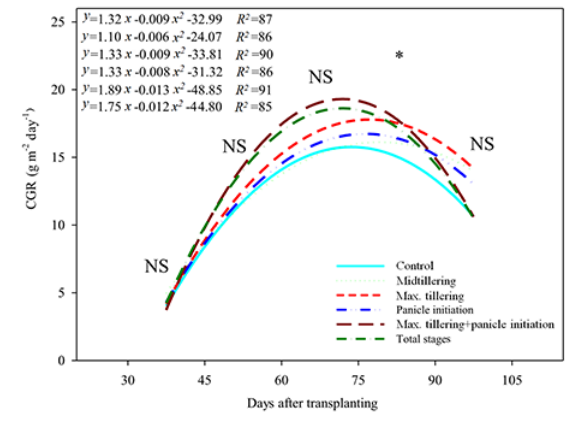
Figure 6 Effect of the foliar application of nutrients on the crop growth rate in different growth stages using the linear regression equation (NS and * mean not significant and significant at 5% probability level,